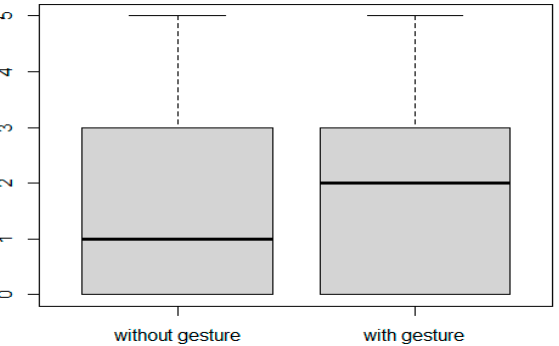
Figure 6. Box plot for testing results in the Expressive Post-Test 2 conditions.